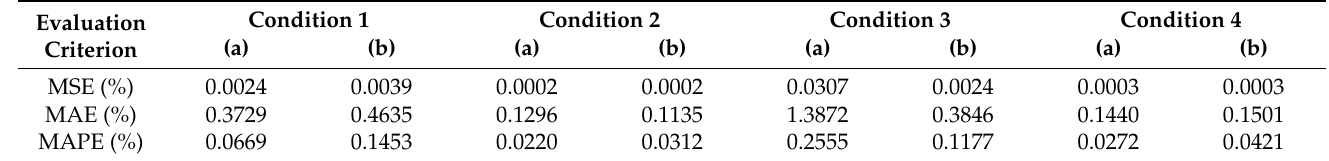
Table 13. The evaluation criterion of the LSTM model.